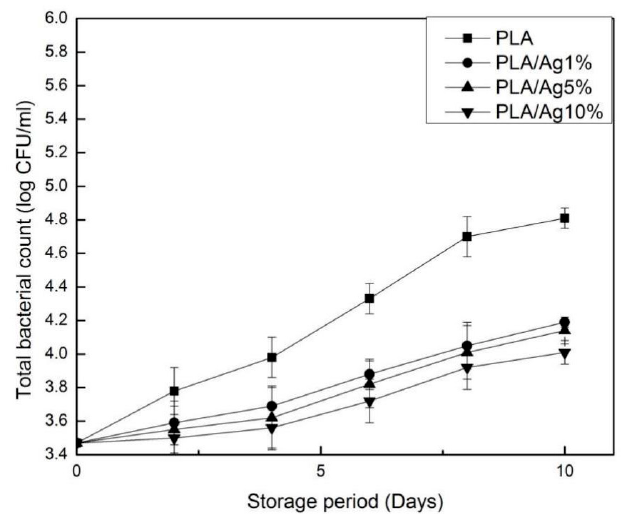
Figure 10. Effect of different concentration of nano-Ag active packages on the account of total bacterial. Data are presented as mean ± standard deviation.